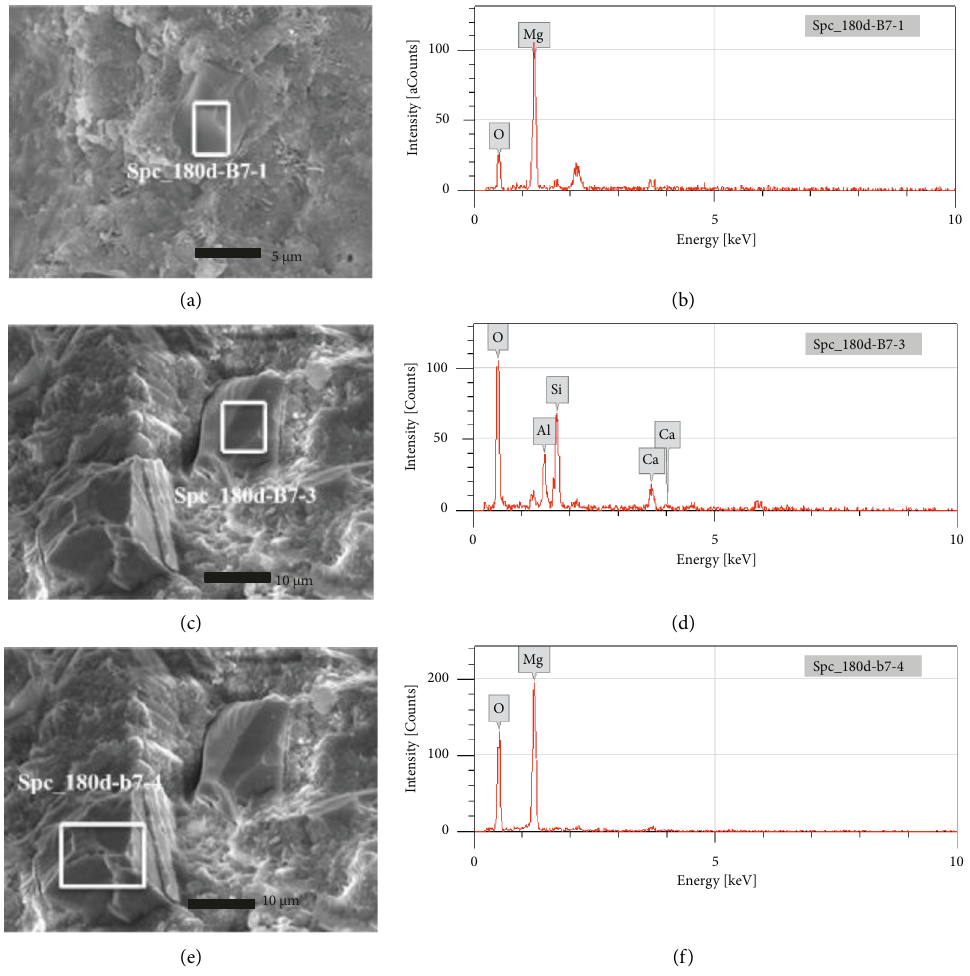
Figure 7: SSP-cement hydration microscopic morphology and energy spectrum analysis with the age of 180d, (a) hydration microstructure with age of 180d, (b) energy spectrum analysis of area Spc_180d_B7-1, (c) hydration microstructure with age of 180d, (d) energy spectrum analysis of area Spc_180d_B7-3, (e) hydration microstructure with age of 180d, and (f) energy spectrum analysis of area Spc_180d_B7-4.